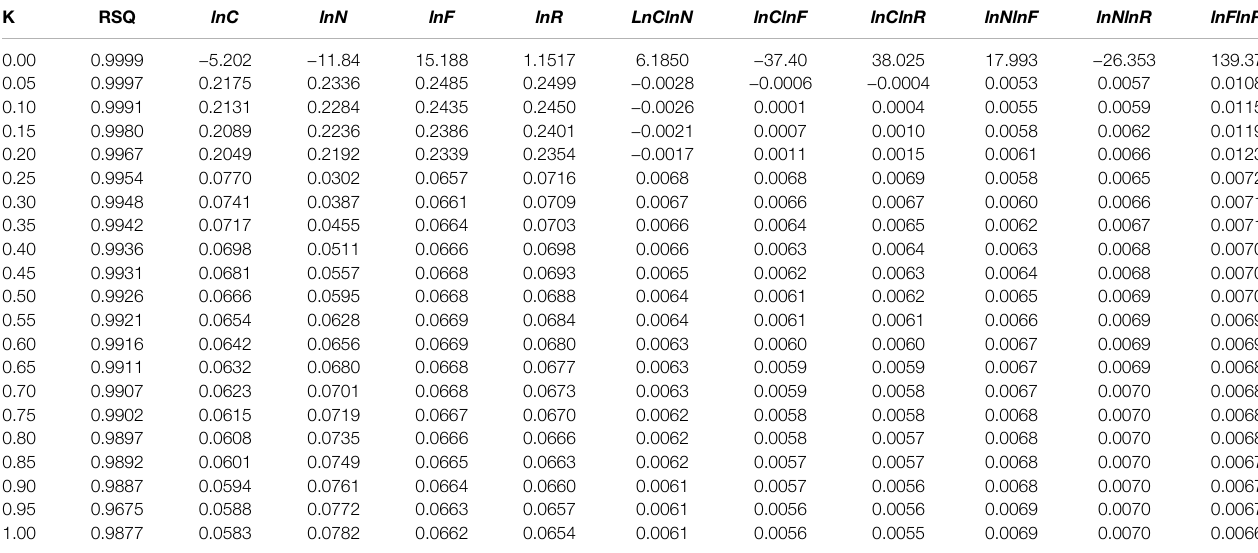
TABLE 1 | Value of R-square and beta coef fi cients when k is given as different constants.